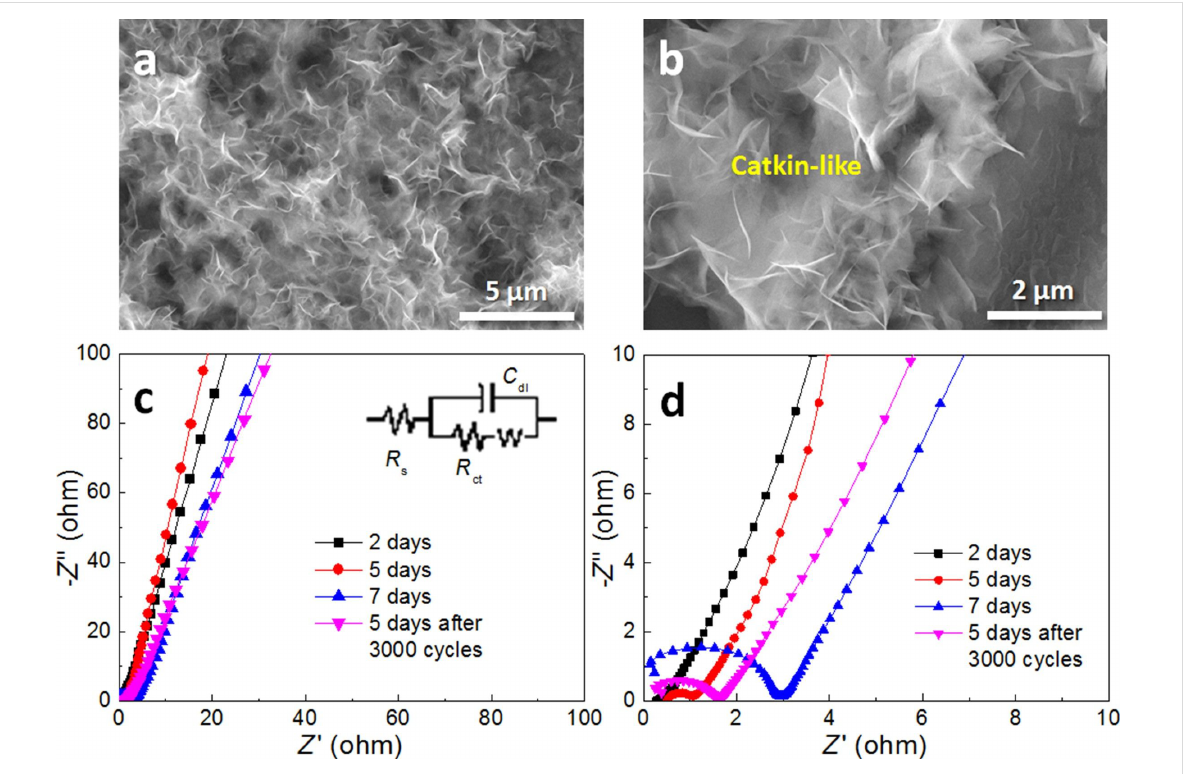
Figure 7: (a, b) Low- and high-magnification SEM images of Ni(OH) 2 /Ni-NF/MG-5 after a 3000 cycles at a GCD current density of 1 A/cm 3 ; (c, d) Nyquist plots of Ni(OH) 2 /Ni-NF/MG-2, Ni(OH) 2 /Ni-NF/MG-5, Ni(OH) 2 /Ni-NF/MG-7 and Ni(OH) 2 /Ni-NF/MG-5 after 3000 cycles at a GCD current density of 1 A/cm 3